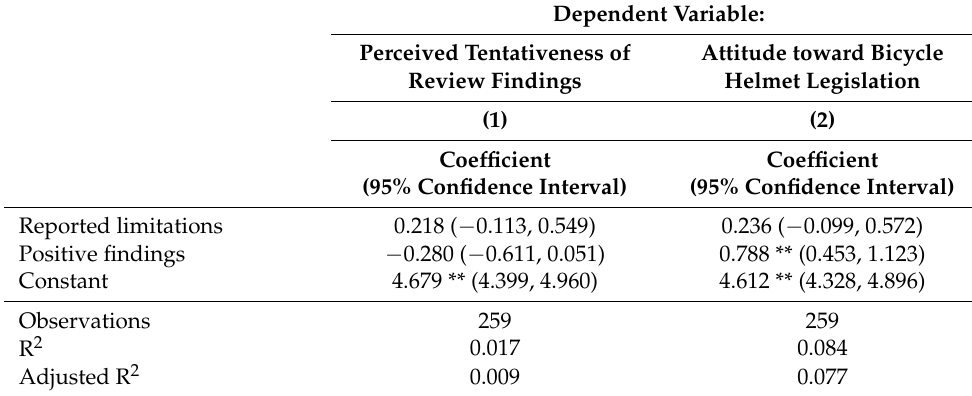
Table 3. OLS regression results for first and second sets of research hypotheses involving experimen- tal factors.